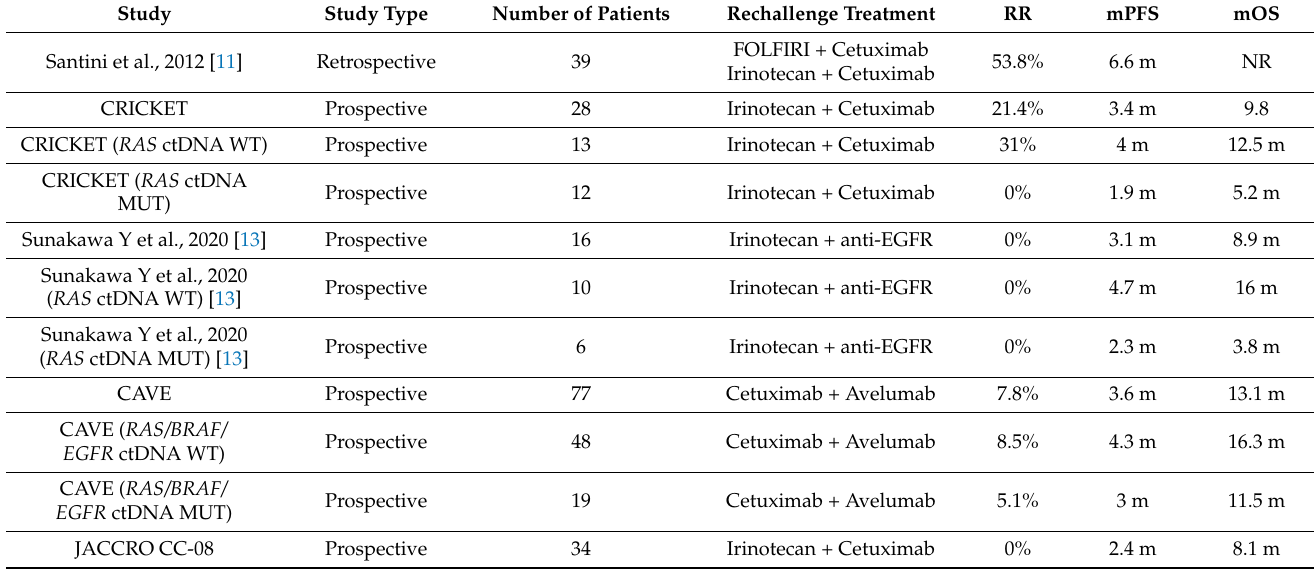
Table 1. Completed rechallenge